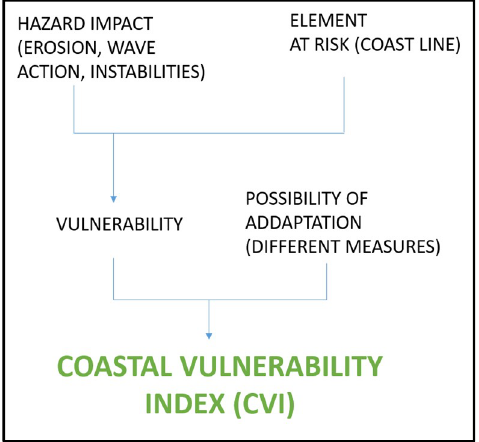
Figure 3. The framework of the Coastal Vulnerability Index assessment.